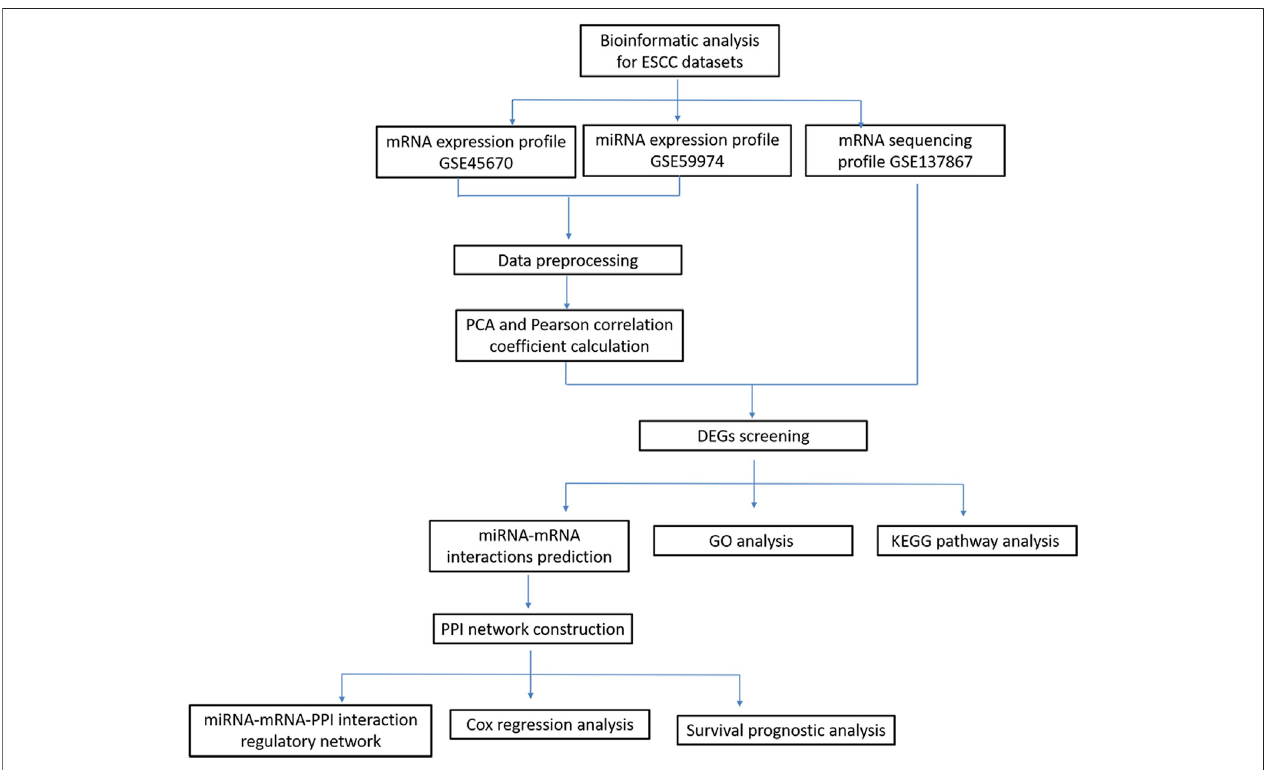
FIGURE 1 | A schematic diagram of bioinformatics analysis for ESCC